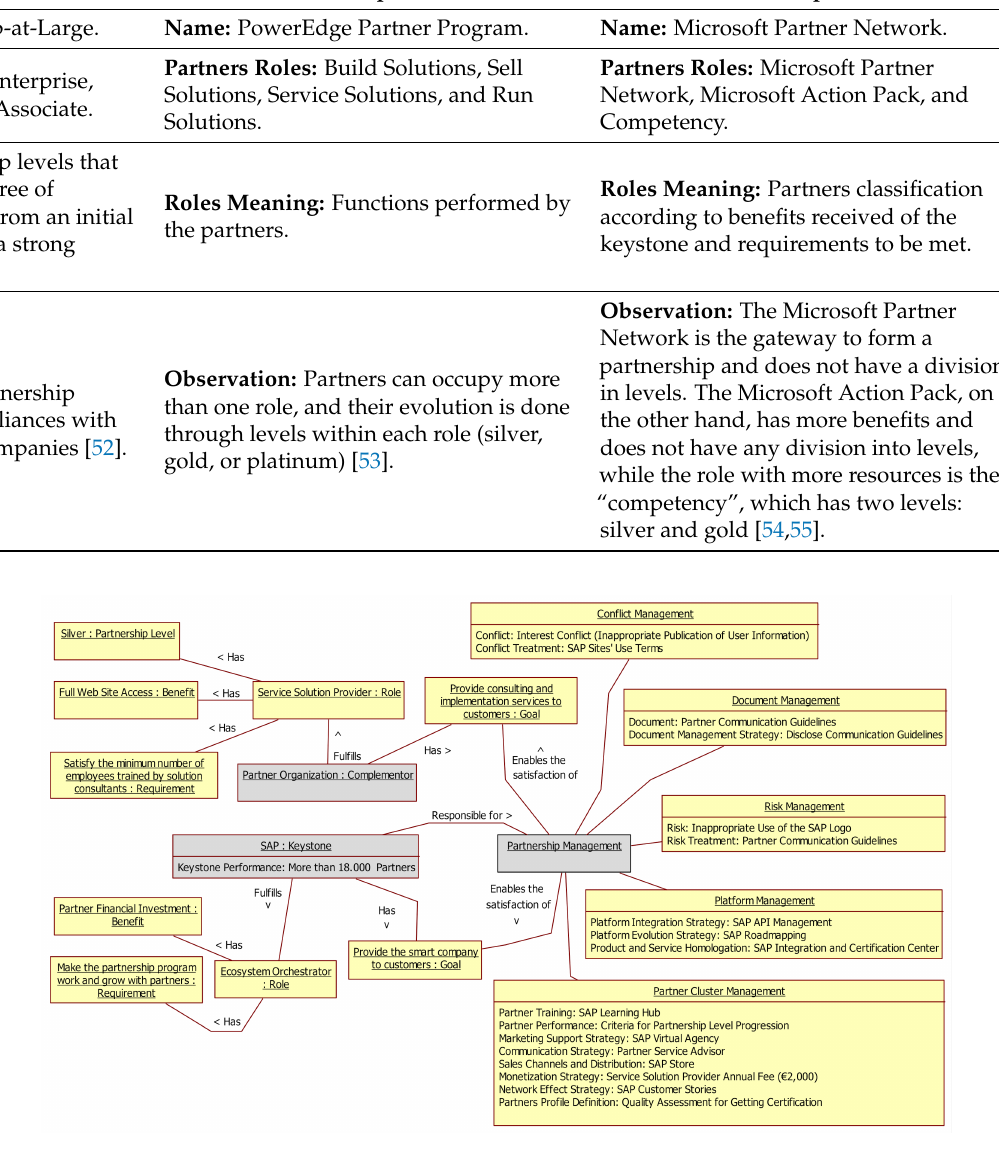
Figure 7. Instantiation of the partnership meta-model for the SAP